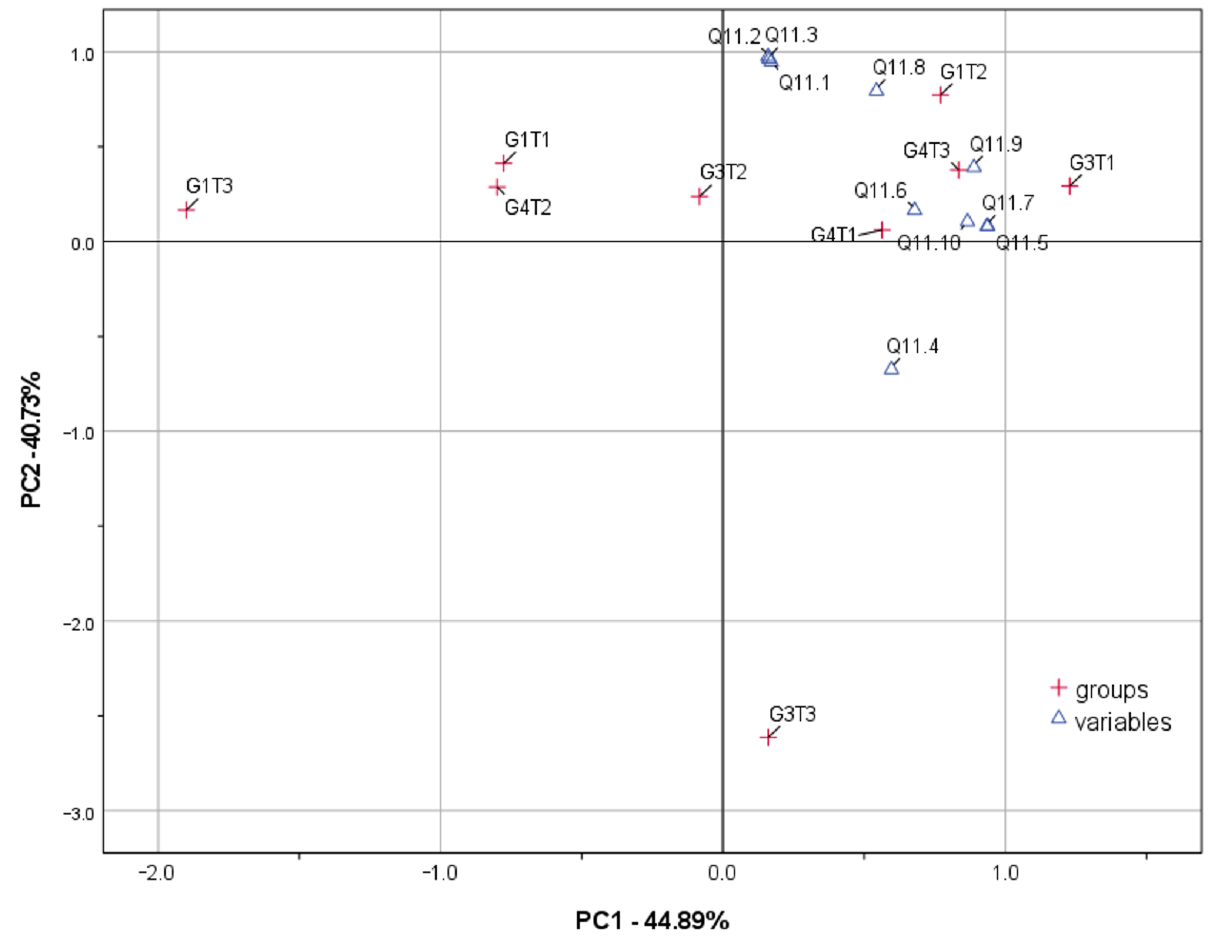
Figure 4. Biplot of relationships of variables (Q11.1, . . . , Q13.10) for groups (G1T1, . . . , G1T3, G3T1, . . . , G4T3) representing types of organization subdivided according to the declared level of trust in the space of the first two components PC1 and PC2.